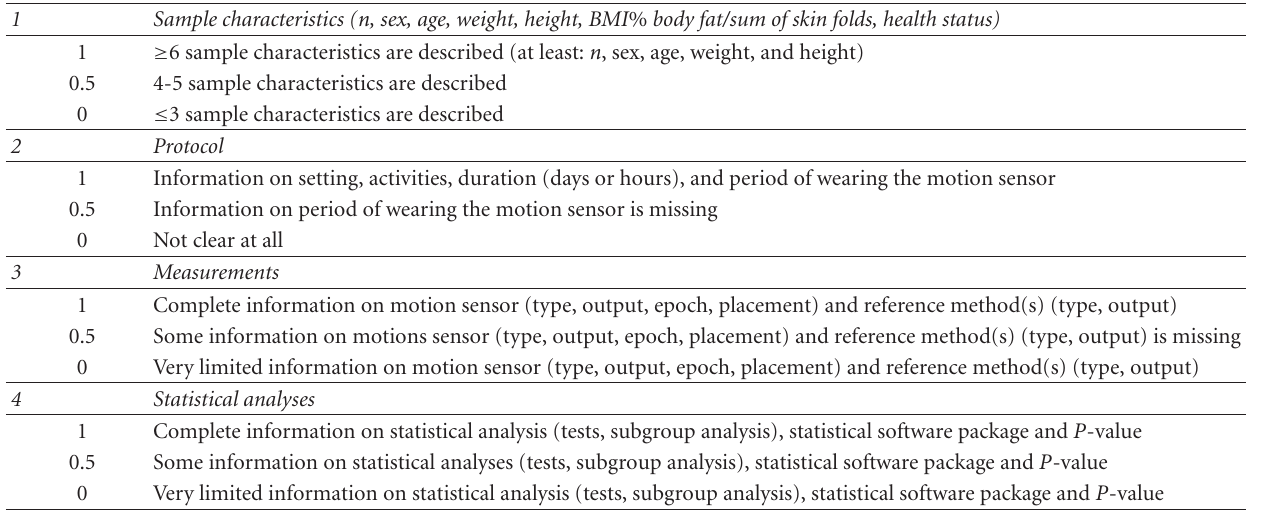
Table 2: Items concerning study